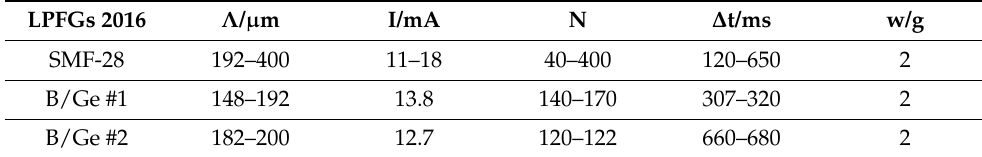
Table 2. Fabrication parameters of the LPFGs from